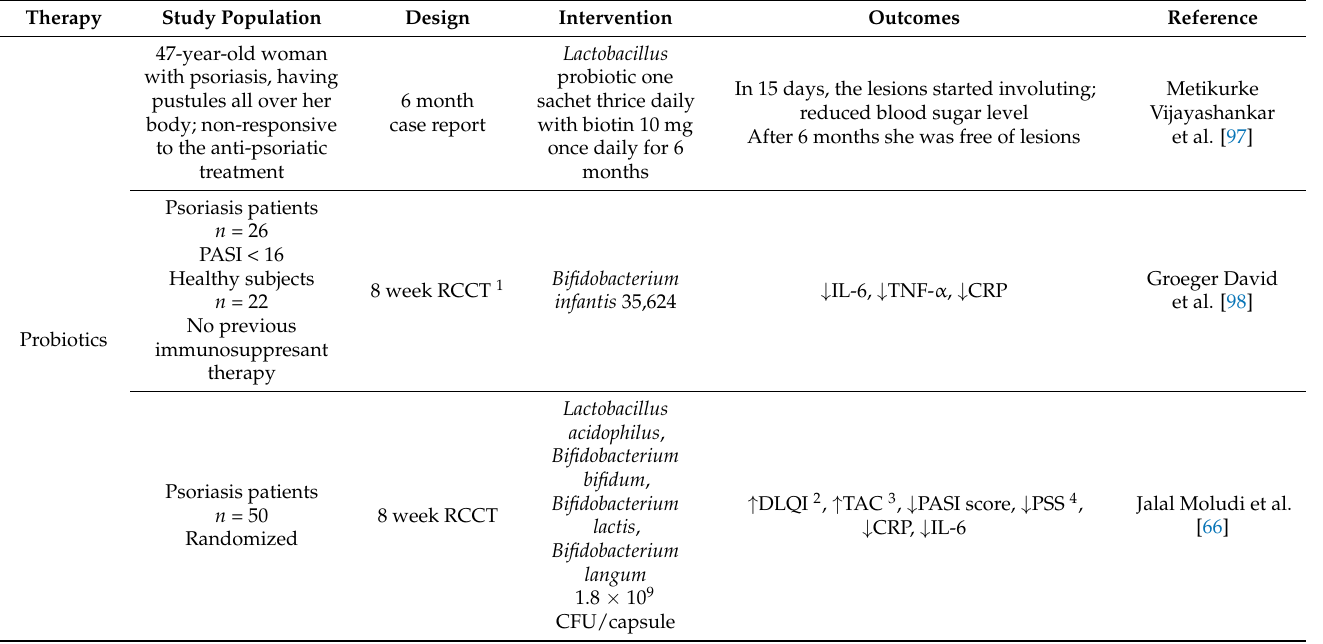
Table 2. The effect of probiotics, synbiotics and bioactive dietary components supplementation in human